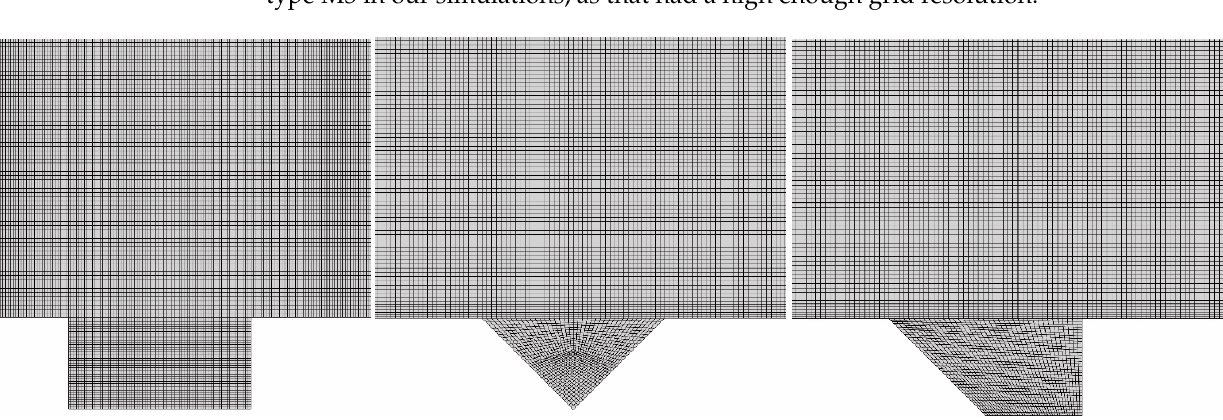
Figure 4. The results of mesh convergence analysis in the simulations. 2.4. Experiment Methods The wind tunnel experiment for the microstructures included two parts, one of which was a small-area microstructure constructed by machining on the surface of a cylinder, and the other was a large-area test constructed on a flat plate. 2.4.1. Experiment Setup for Cylinder Model The cylinder experiment was performed in a subsonic wind tunnel that had a rectangular test section of 3 m × 3 m (width × height) with the maximum velocity of 100 m/s. Figure 4a illustrates the sketch of the experiment. The diameter and length of the cylinder were 70 mm and 300 mm, respectively. The axis of the cylinder was parallel to the velocity direction. The groove direction was along the circumference of the cylinder,